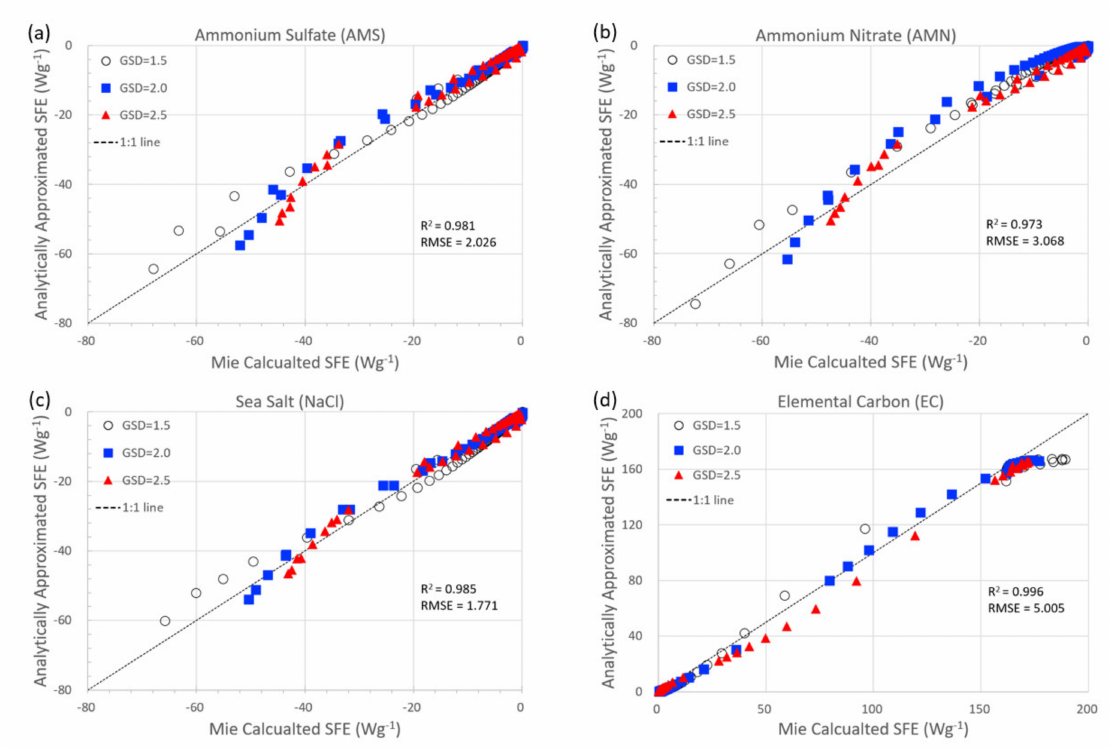
Figure 8. Comparison between the simple forcing e ffi ciency (SFE) calculated using analytical approximation and those using Mie theory-based calculation for ( a ) ammonium sulfate (AMS), ( b ) ammonium nitrate (AMN), ( c ) sea salt (NaCl), and ( d ) elemental carbon (EC) with geometric standard deviations (GSD) of 1.5, 2.0, and 2.5. The correlation coe ffi cient ( r 2 ) and root mean square error (RMSE) are embedded in each panel. The black dotted line in each panel is a 1:1